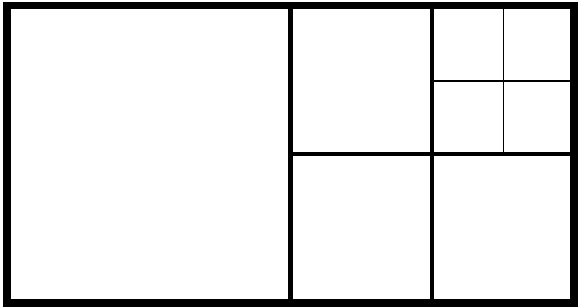
Figure 5. Depiction of 8 × 16 image with three-level quadtree